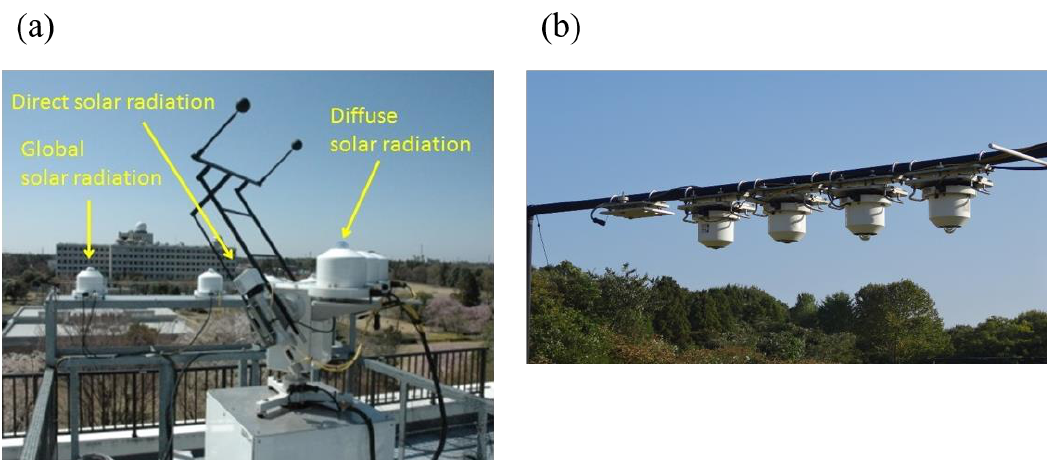
Figure 1. Topography of dx500m and the location of the Tsukuba station (yellow square). The yellow dashed rectangle indicates the Tokyo electric power company (TEPCO) area.